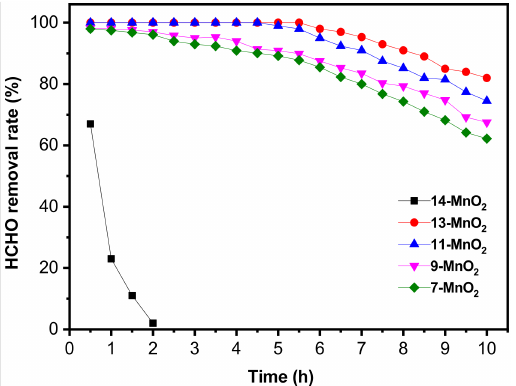
Figure 1. Influence of pH on catalytic activity; reaction conditions: reaction temperature = 25 ◦ C,